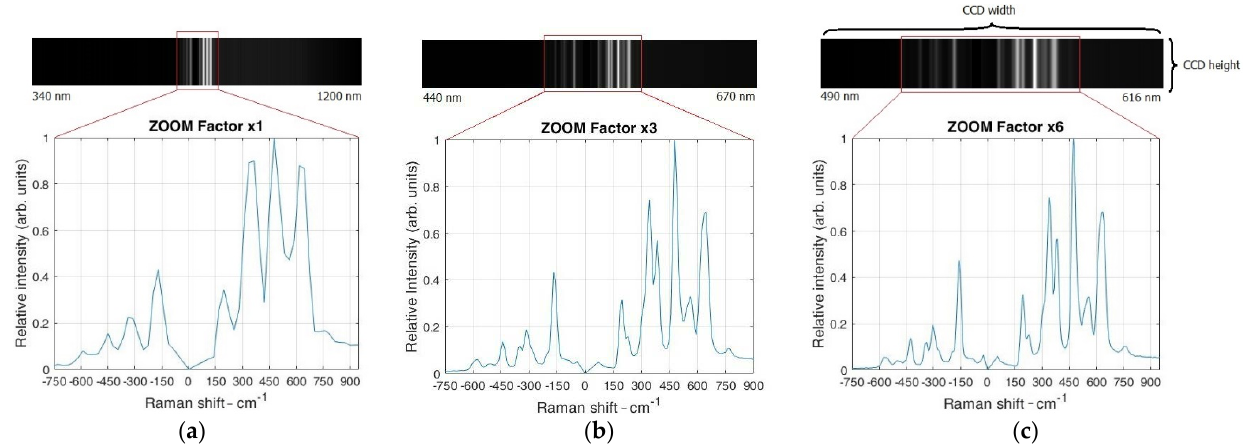
Figure 3. Acquired image over the CCD region and a Raman spectrum of a ZrO 2 with different zoom factors, ( a ) for a ZF of 1×, ( b ) for 3×, and ( c ) maximum ZF of 6× .